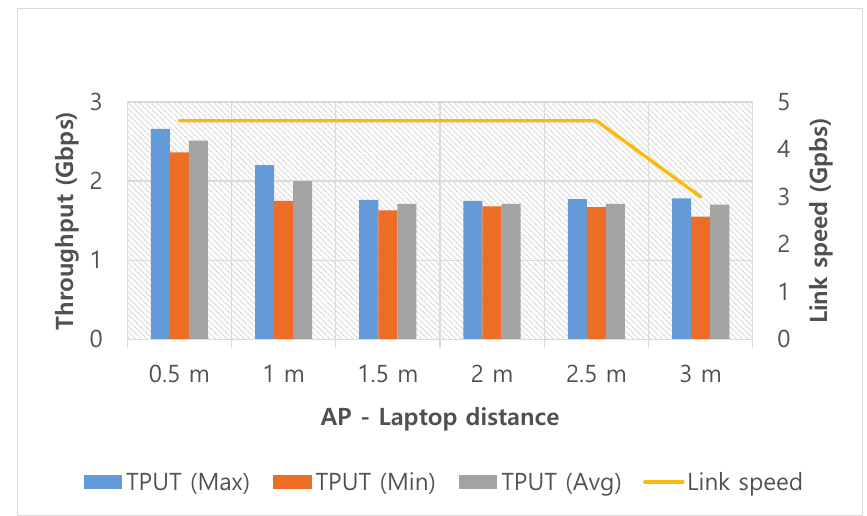
Figure 2. Throughput performance of WiGig at various distances.